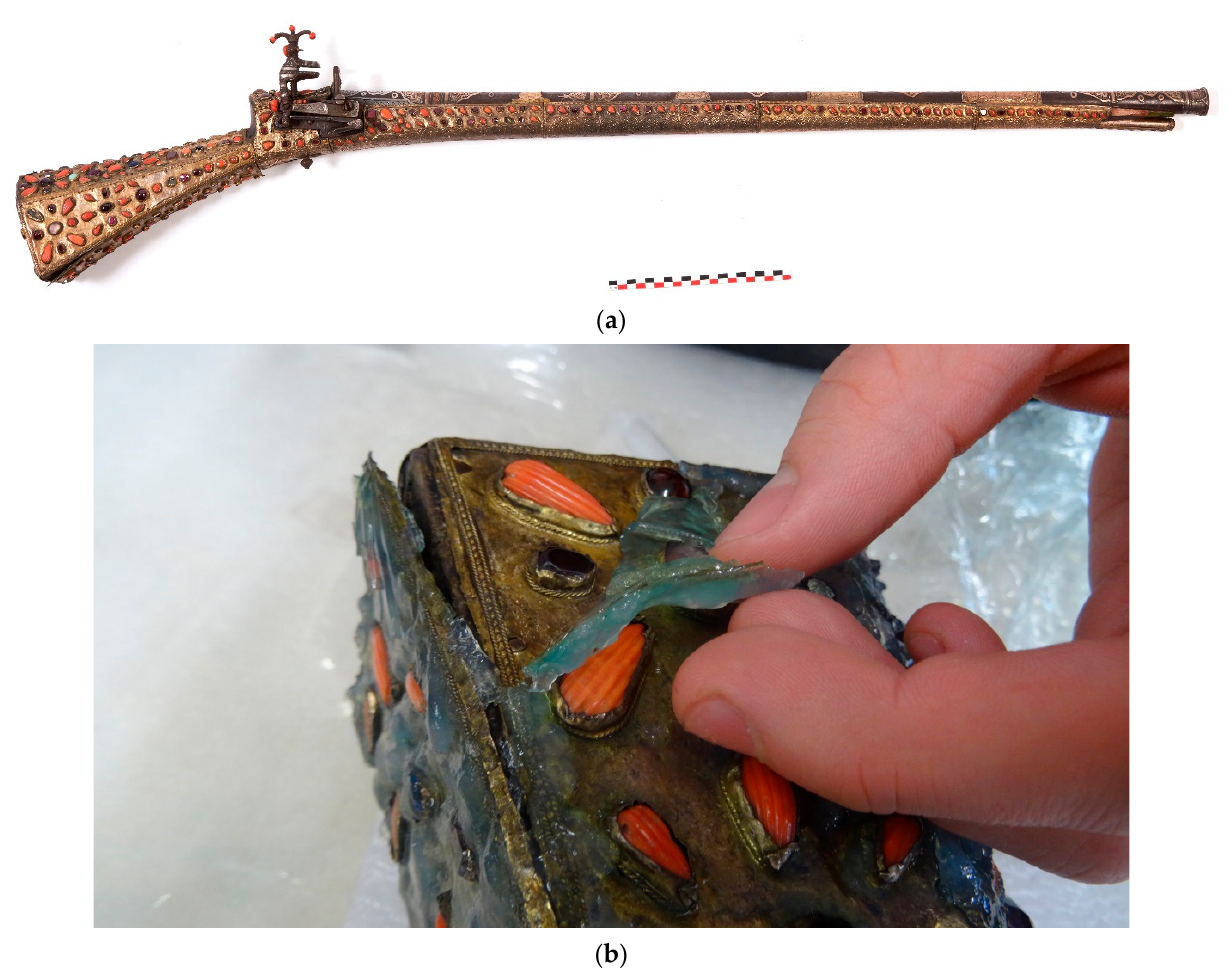
Figure 1. The gun from the Pierre Loti Museum collection ( a ), removal of the agar gel ( b ) (© J.G. Aubert/Arc’Antique—Grand Patrimoine de Loire Atlantique, Nantes, France).